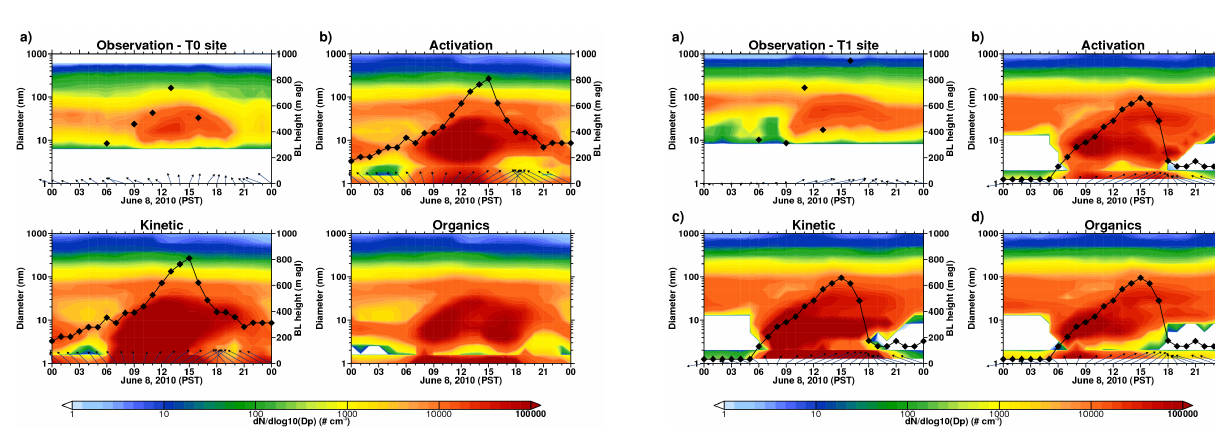
Figure 3. Number size distribution as a function of geometric di- ameter and time at the T0 site on 8 June 2010 and from (a) obser- vations and the (b) ACT, (c) KIN, and (d) ORG simulations. The vectors along the bottom of each panel represent the observed and calculated winds at 10m above ground level (a.g.l.) at the T0 site. The maximum wind speed at about 15:00PST in (b) – (d) is 6ms − 1 . The black diamonds represent the observed (a) and simulated (b–d) boundary-layer heights.